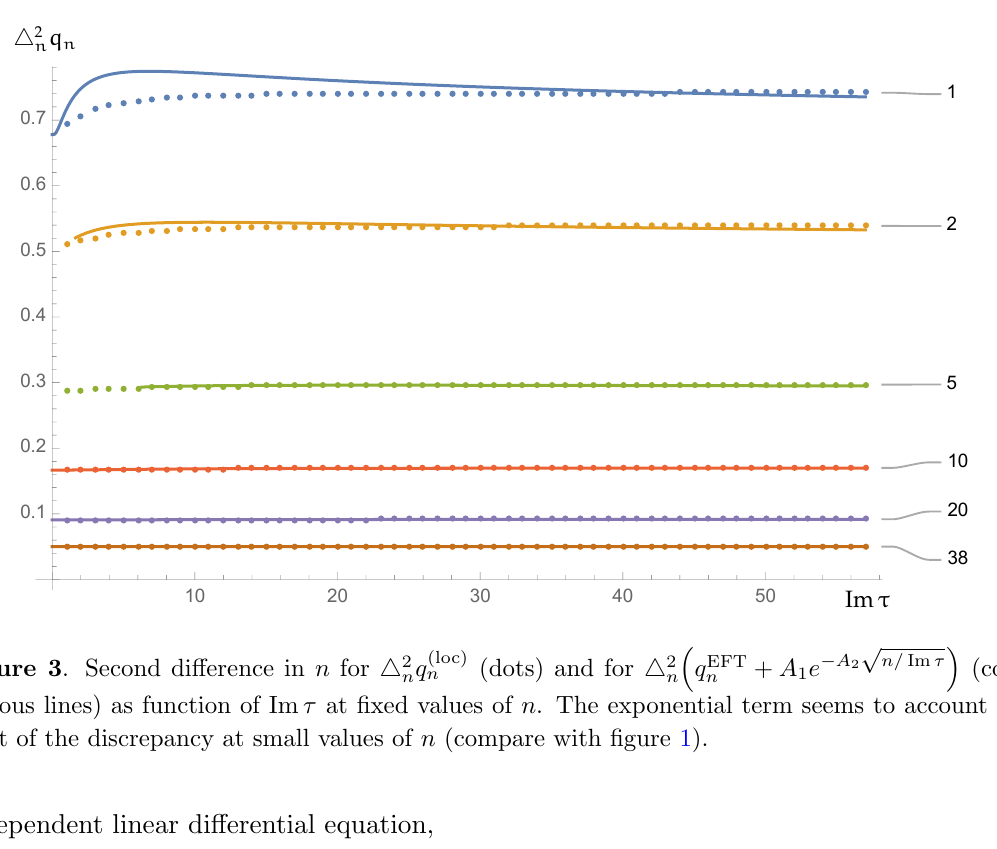
2 q EFT + A 1 e (cid:0) A 2 p n= Im (cid:28) n n 4 (cid:16)